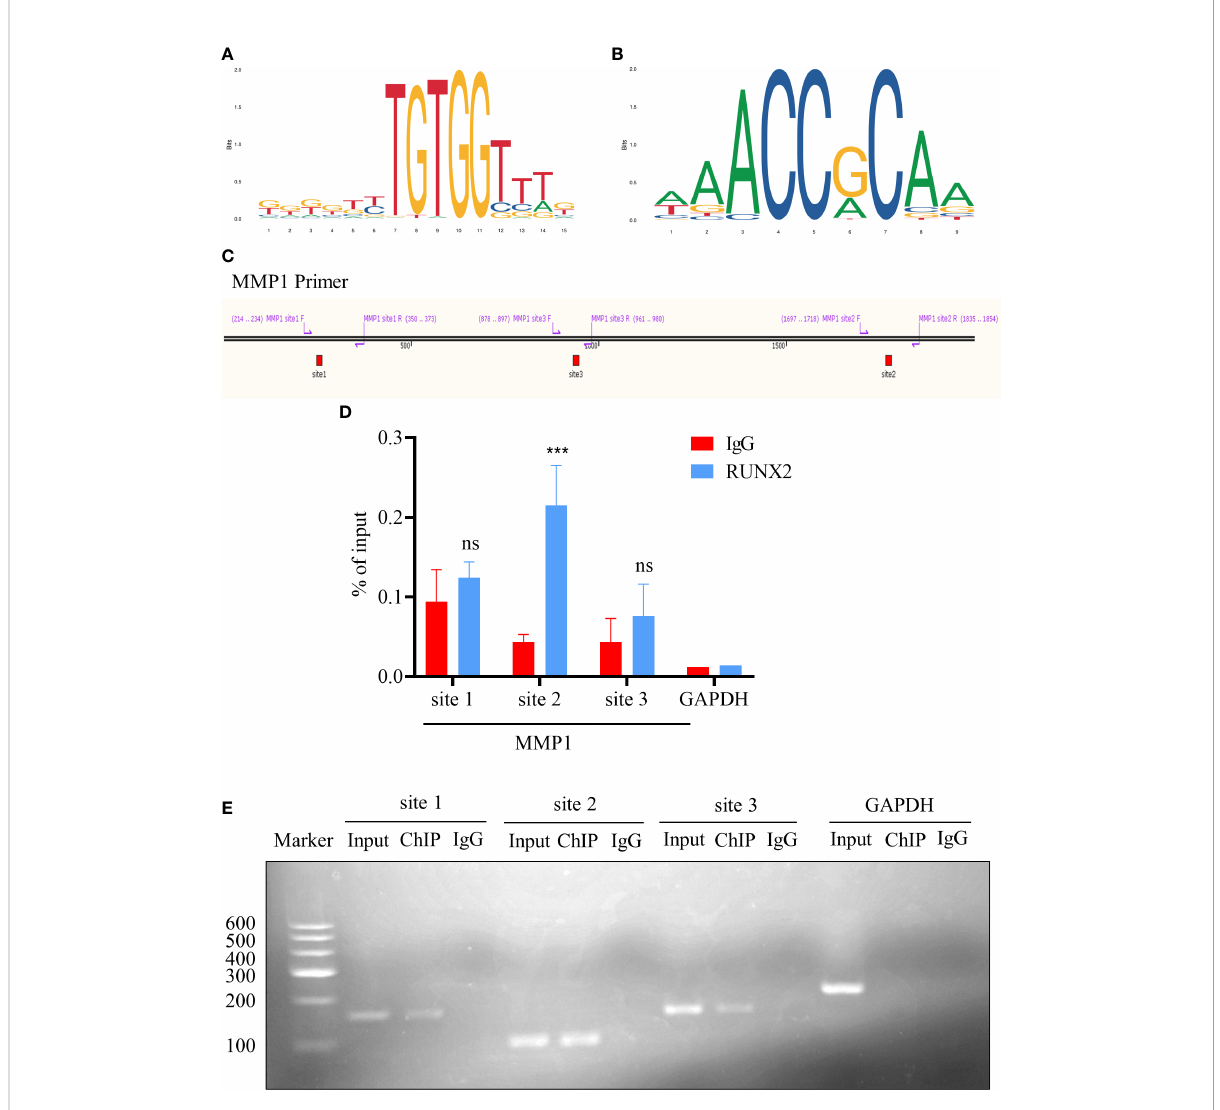
FIGURE 9 RUNX2 binds directly to the MMP1 promoter region. (A, B) The binding motif prediction of the RUNX2 according to the jaspar database. (C) Illustration of the three potential RUNX2 binding sites in the MMP1 promoter region. (D) ChIP-qRT-PCR analysis of the binding sites of RUNX2 in the MMP1 promoter region in MDA-MB-231-Re cells. (E) Agarose gel electrophoresis analysis of RUNX2 binding to the MMP1 promoter region in MDA-MB-231-Re cells. All data were shown as mean ± SD (N=3 independent samples). ***P<0.001; ns, not signi fi cant.